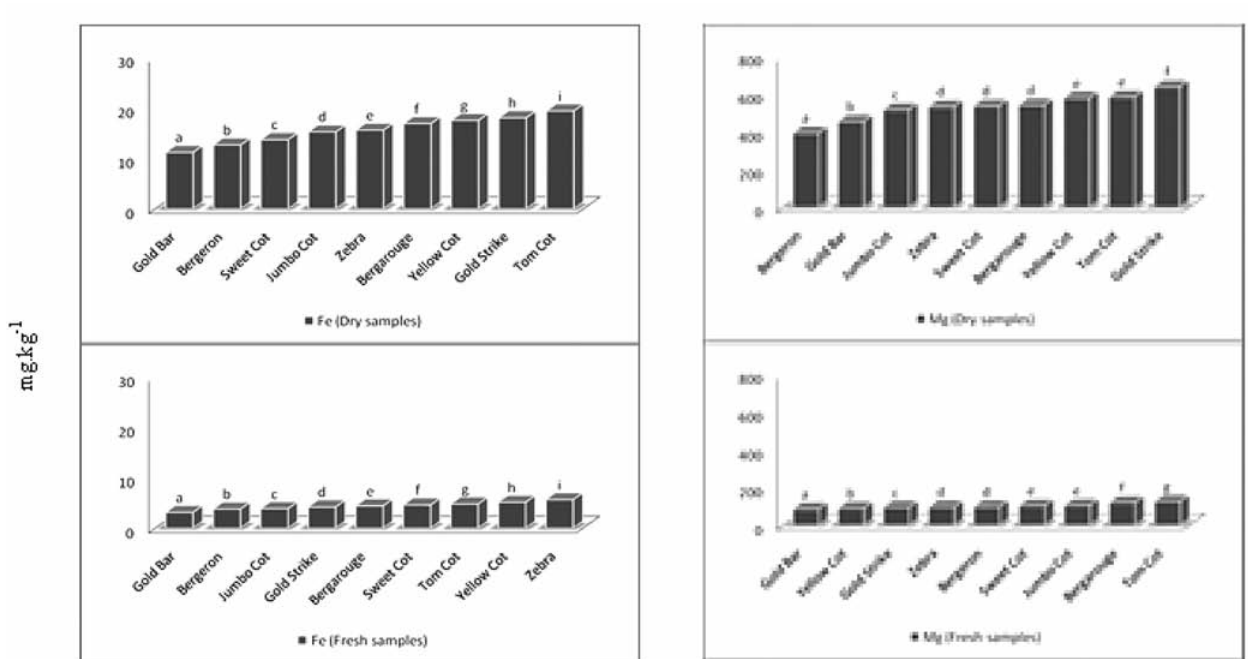
Figure 3. Concentration of Iron in apricot cultivars (mg.kg-1), columns with different caption have a significant difference (P